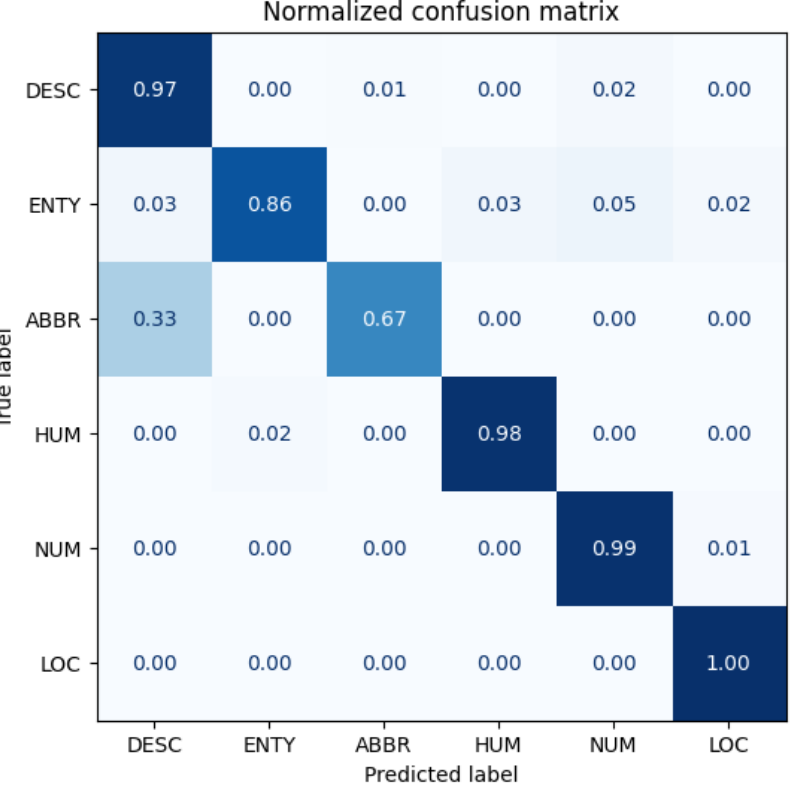
Figure 17. Antonym3 Run1 Confusion Matrix on TREC.